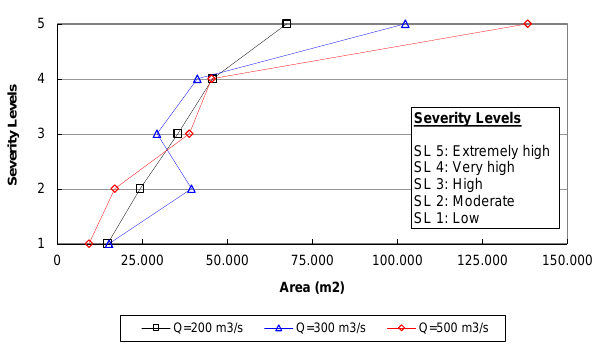
Fig. 20. 2-D SWE model. Expected values and standard deviations of the extension of areas with different severity levels for flow case 200m 3 s − 1 .